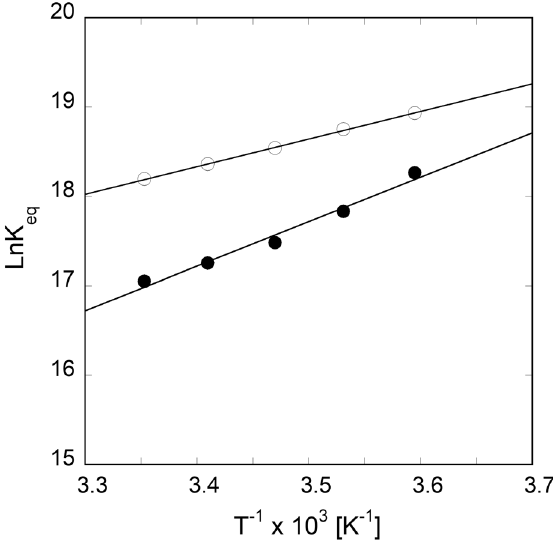
Figure 5. van’t Hoff plots for the interaction of APP IRE mRNA with IRP1 protein in the absence and presence of iron. Temperature-dependent binding affinity of IRP1∙APP IRE mRNA (—Ο—) and IRP1∙APP IRE mRNA-Fe 2+ (— ● —) complex.